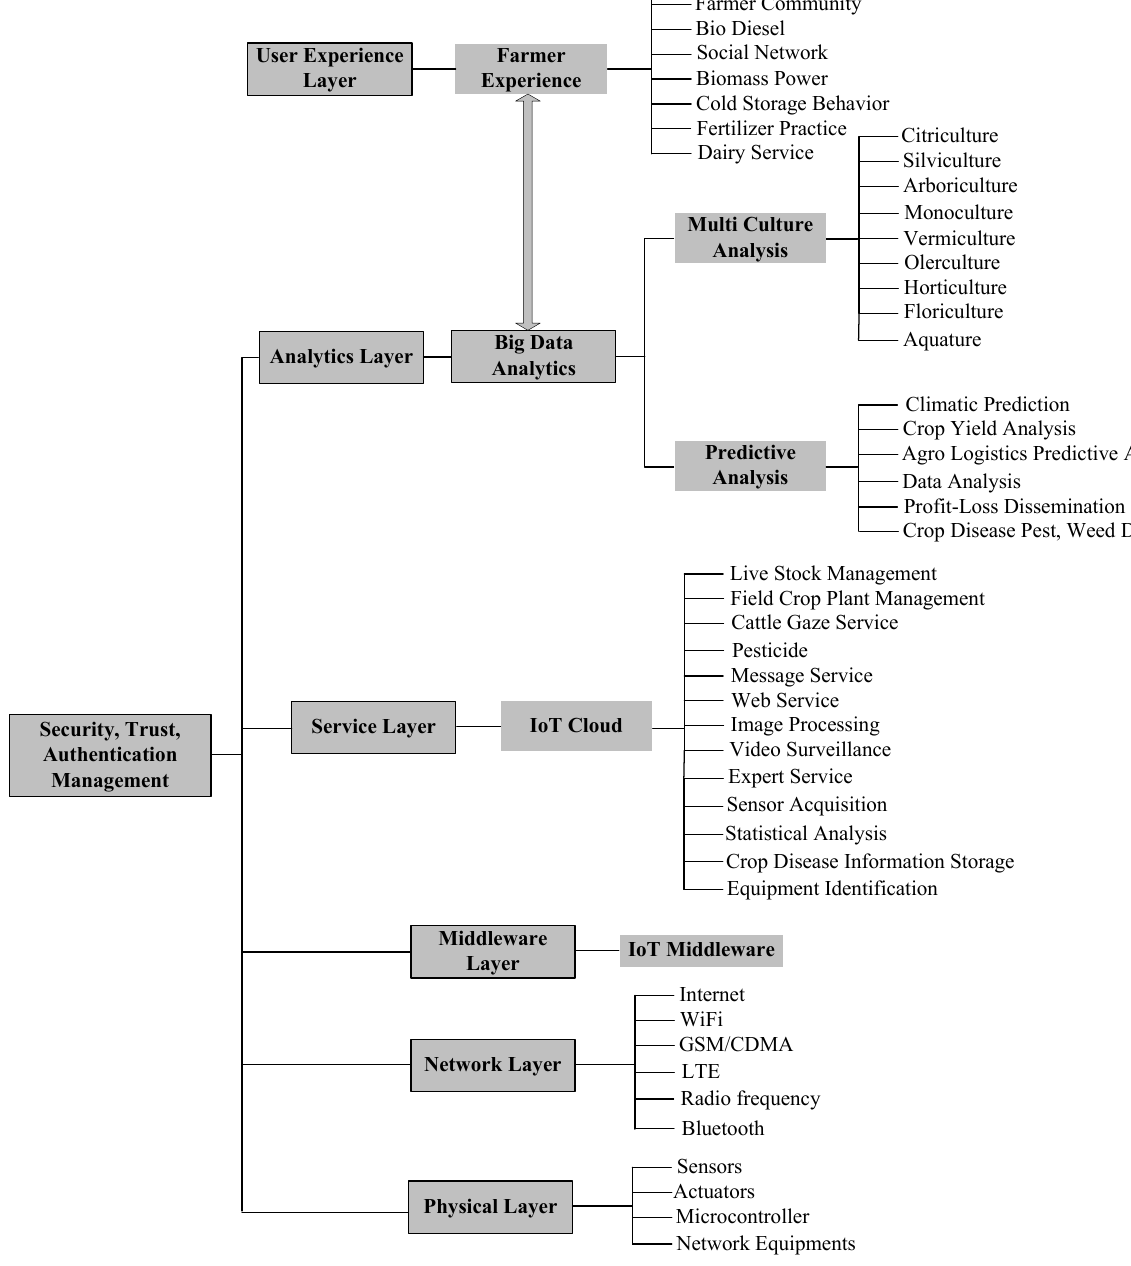
Figure 12. IoT based smart farming framework.